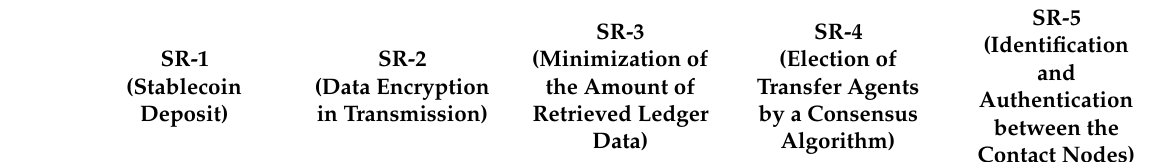
Table 1. Relationship between security threats and security